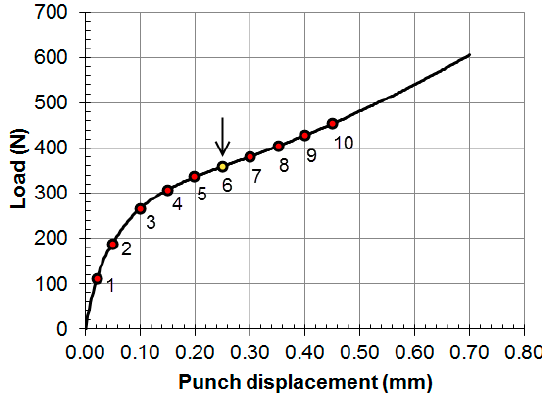
Figure 5. SPT curve for hypothetical bilinear material.